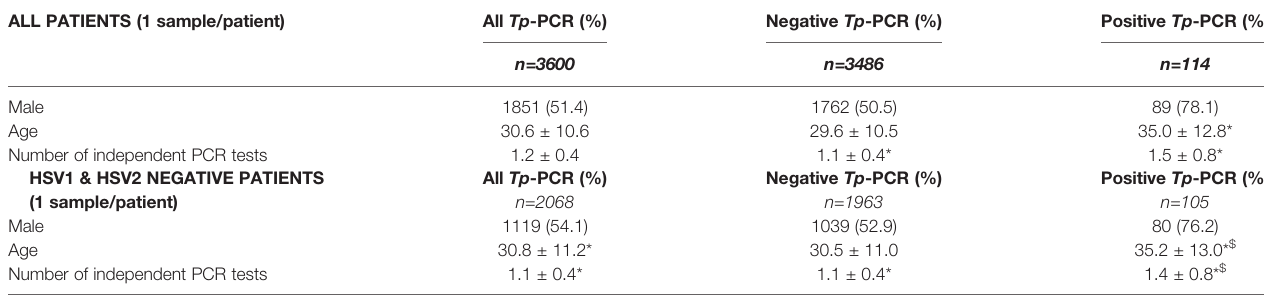
TABLE 1 | Patient characteristics all and HSV1/2 negative persons screened with Tp -PCR for anogenital lesions. ALL PATIENTS (1